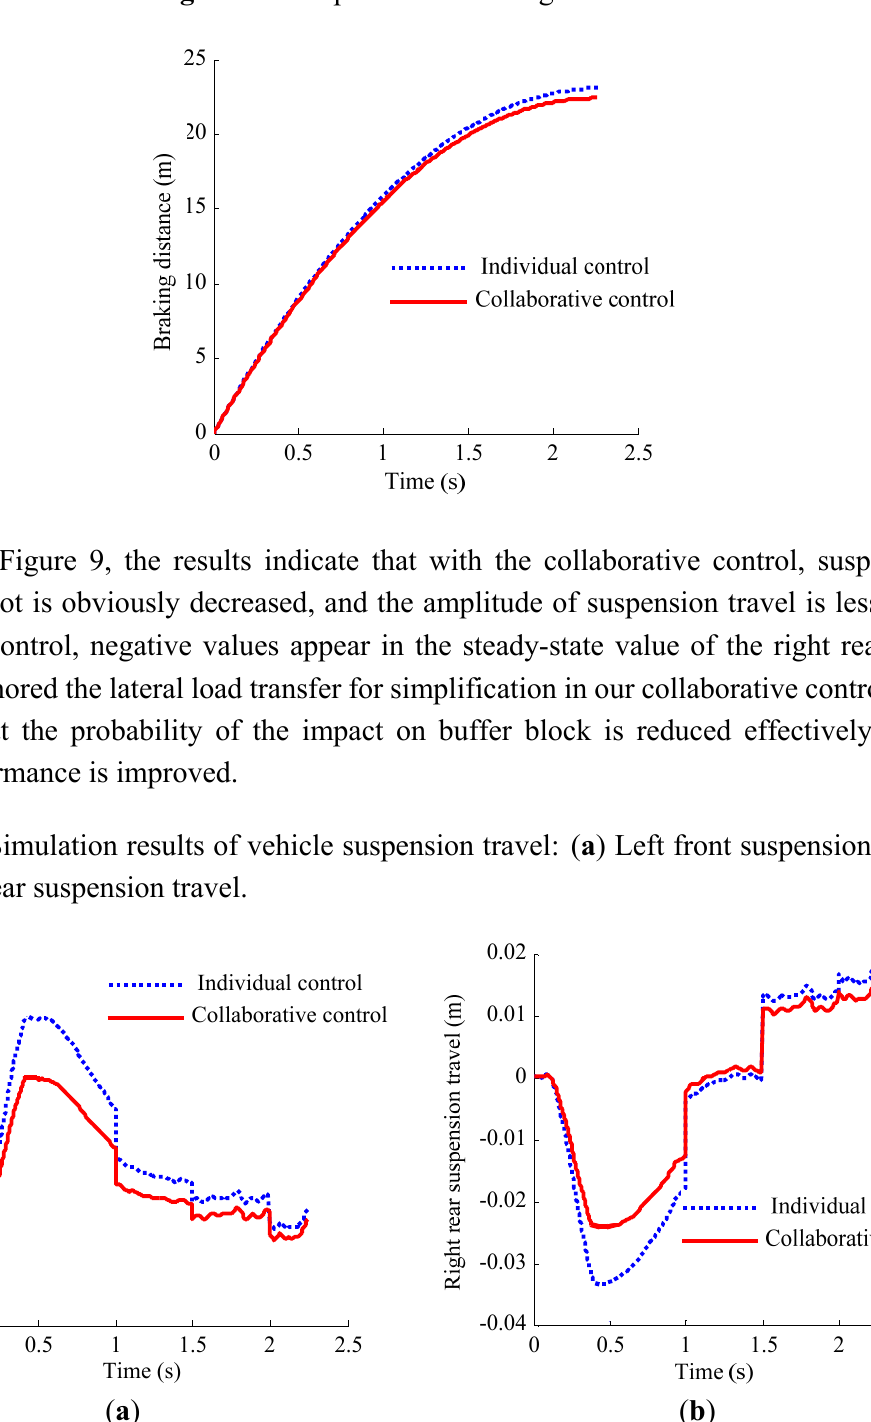
Figure 8. Comparison of braking distance.